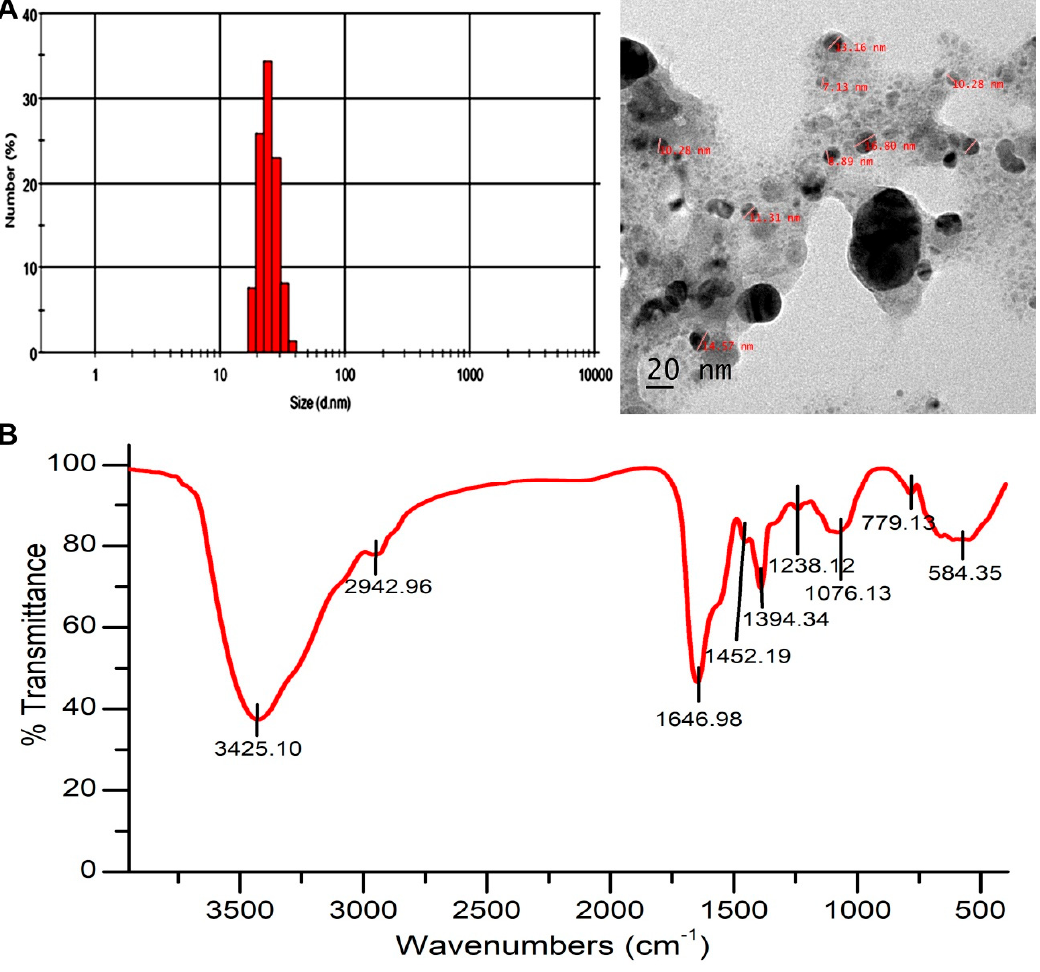
Figure 2. ( A ) Dynamic light scattering (DLS) graph represents the particle size distribution and High-resolution transmission electron microscopy (HR-TEM) micrograph of AgNPs. ( B ) Fourier transform infrared spectroscopic (FTIR) analysis of the biogenic AgNPs.